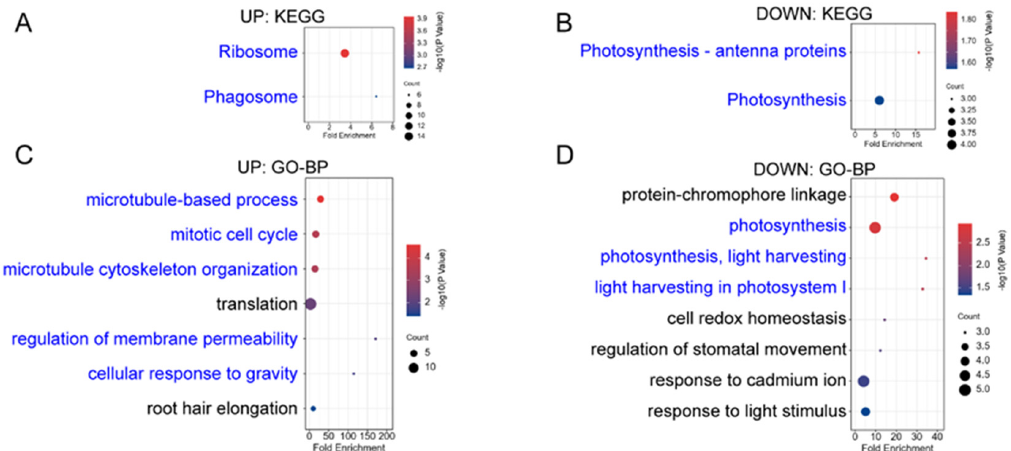
Figure A1. KEGG and GO enrichment analysis of the first repetition of differentially expressed proteins (DEPs-Rep1, ICFI ≥ 1.5) in “ upl5-1 vs. Col-0” group. ( A , B ) KEGG enrichment analysis of up-regulated DEPs-Rep1 ( A ) and down-regulated DEPs-Rep1 ( B ); ( C , D ) GO enrichment analysis-biological process of up-regulated DEPs-Rep1 ( C ) and down-regulated DEPs-Rep1 ( D ).